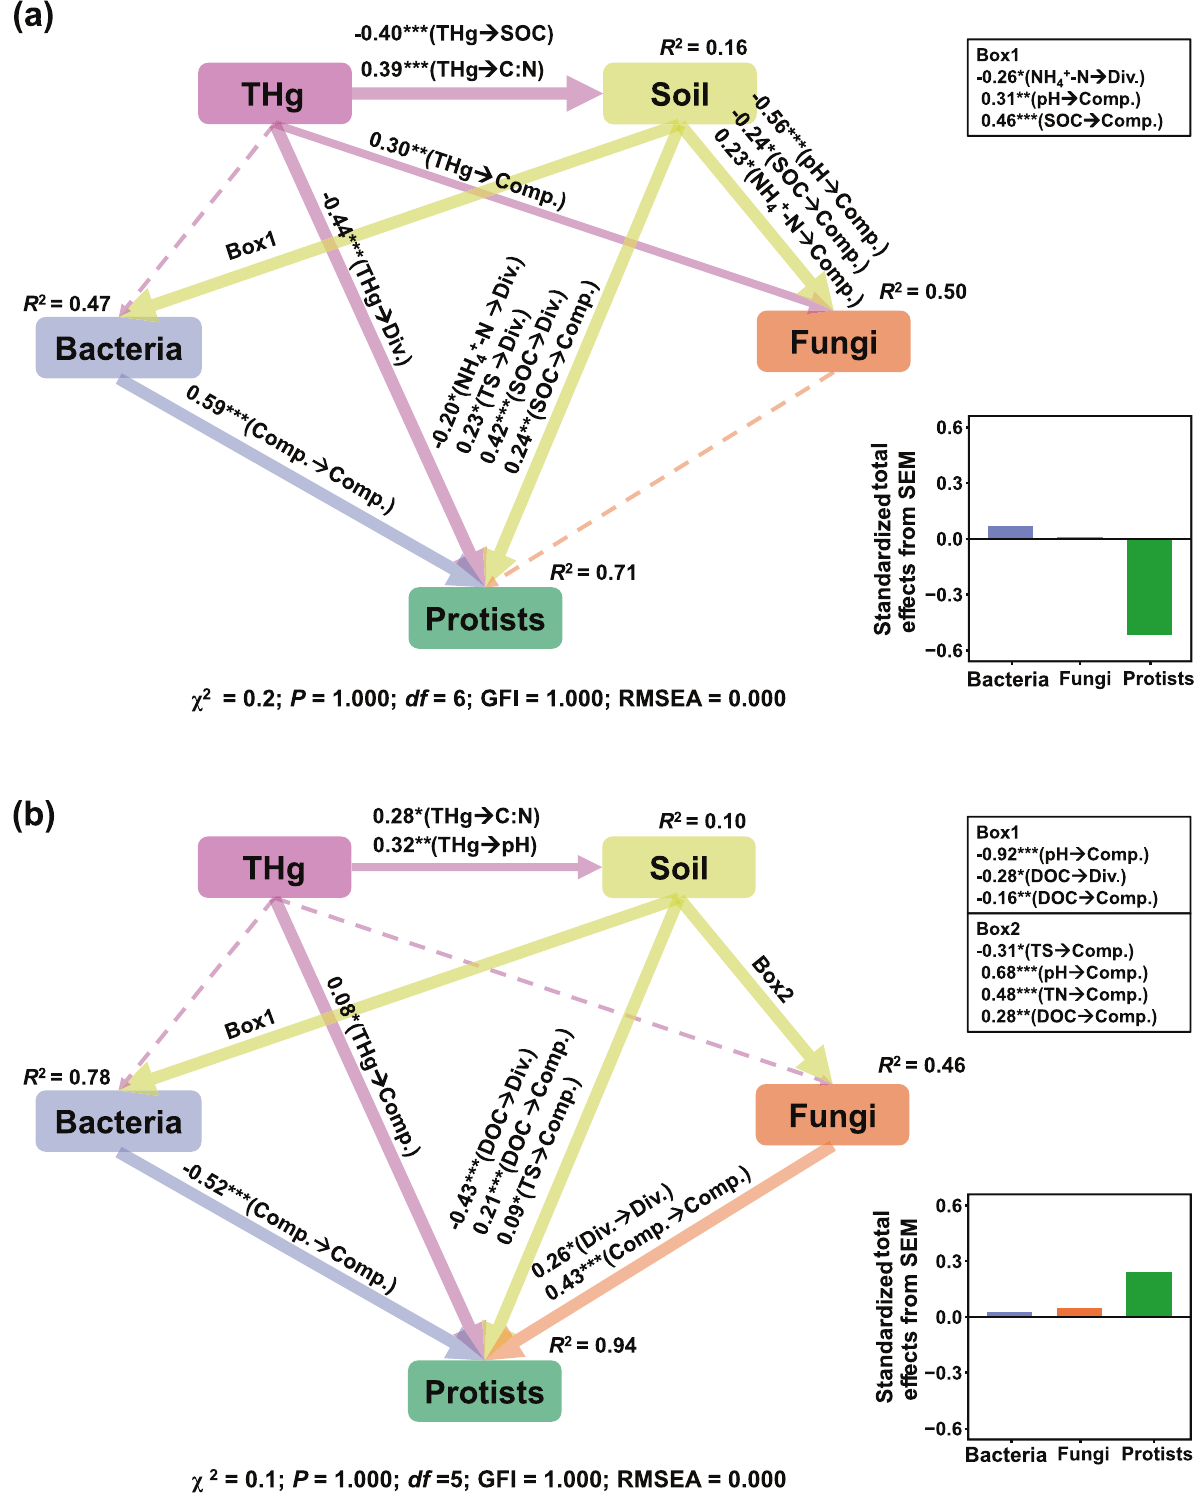
Fig. 5 Structural equation models illustrating the associations between Hg pollution and soil microbial communities. The associations were shown in paddy ( a ) and upland ( b ) soils. Continuous and dashed arrows represent the signi fi cant and nonsigni fi cant relationships, respectively. Numbers labeled adjacent to the arrow represent the path coef fi cients, and the width of arrow is in proportion to the degree of path coef fi cients. R 2 values indicate the proportion of variance explained by each variable. Signi fi cance levels are denoted with * P < 0.05, ** P < 0.01 , and *** P < 0.001. Div. diversity, Comp. community composition, SOC soil organic carbon, DOC dissolved organic carbon, TN total nitrogen, TS total sulfur, C:N carbon nitrogen